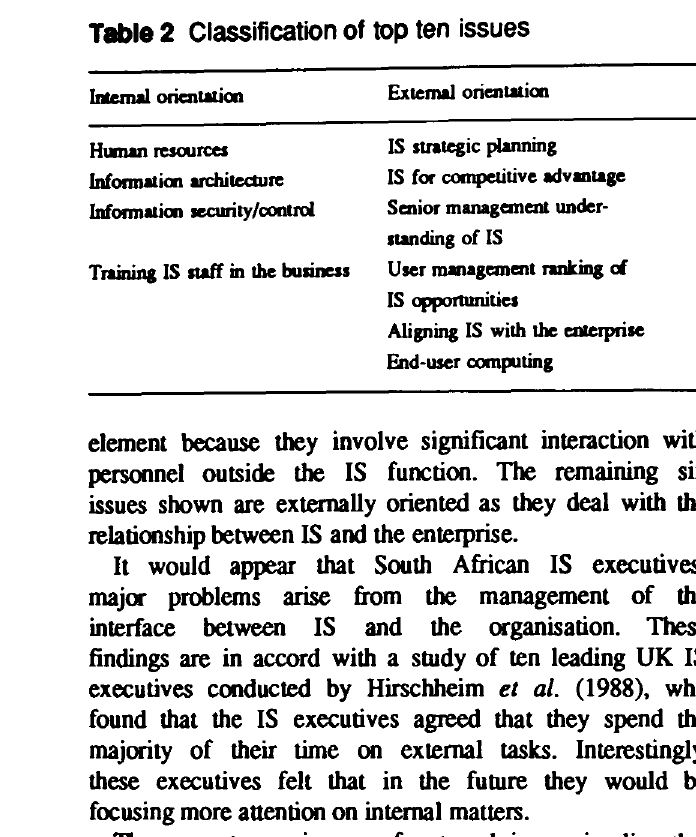
Table 2 Classification of top ten